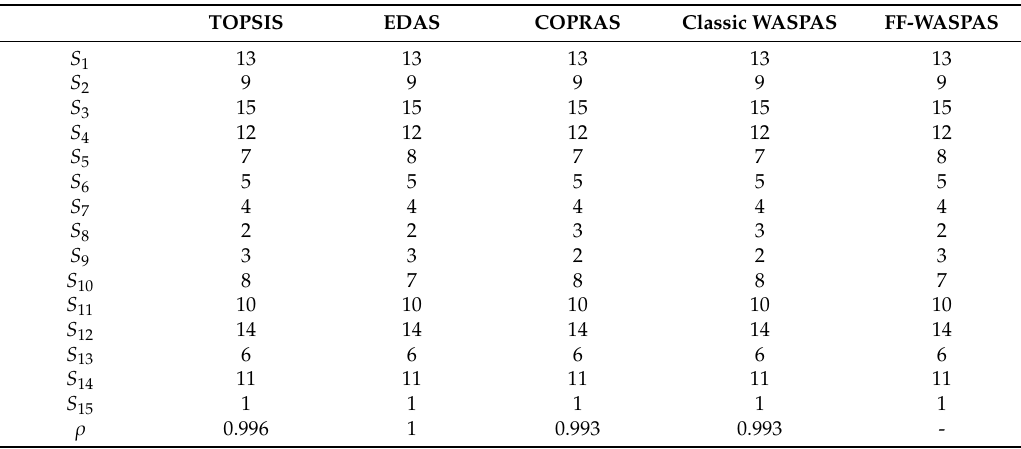
Table 13. The rank of alternatives obtained by di ff erent